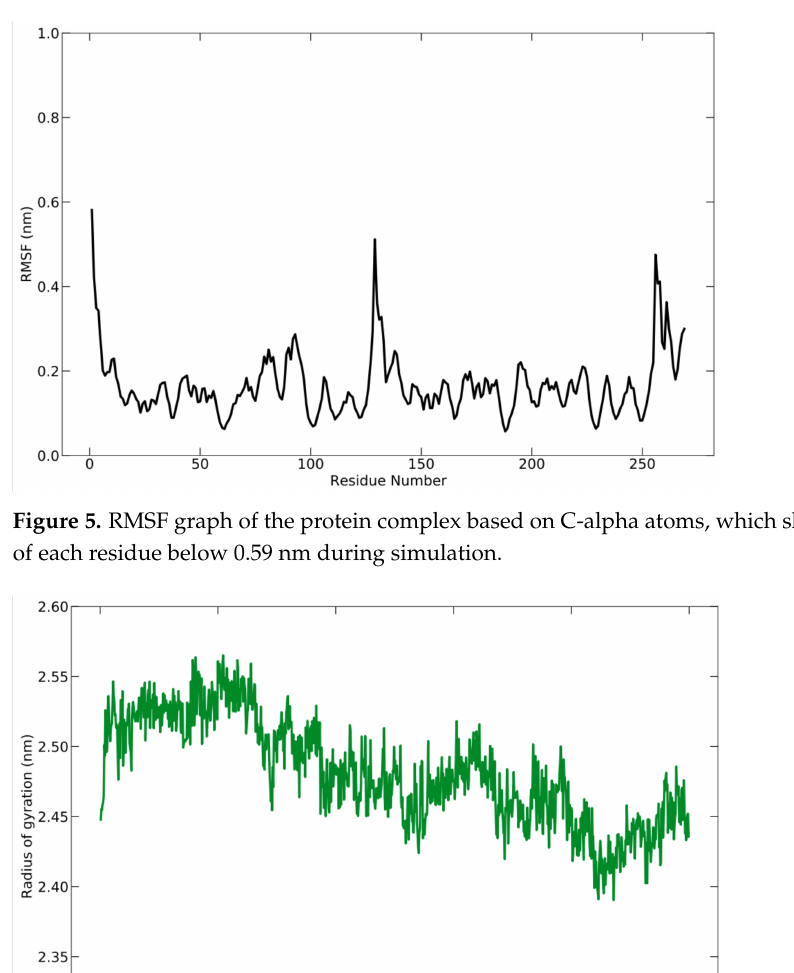
Figure 4. RMSD graph for protein backbone (in blue), peptide (in red), and the protein–peptide complex (in black) during 100 ns simulation.